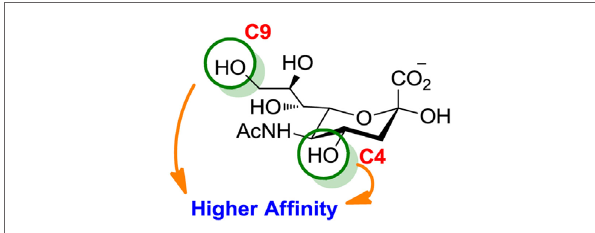
FiGURe 6 | Modifications of neuraminic acid leading to high-affinity siglec blockers . Green circles denote the main positions modified in search of high-binding affinity and selective siglec